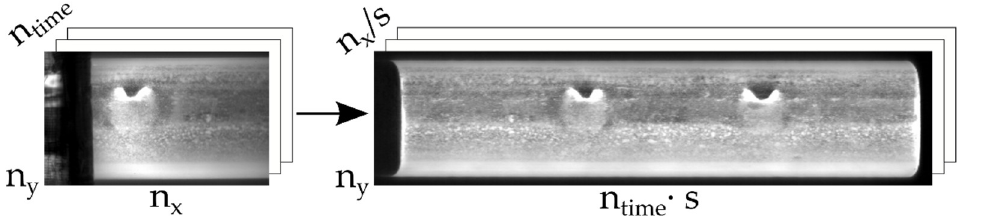
Figure 18. Scheme of conversion of rectified n x × n y × n time sequence to quasi static n time ·s × n y × n x /s image sequence.